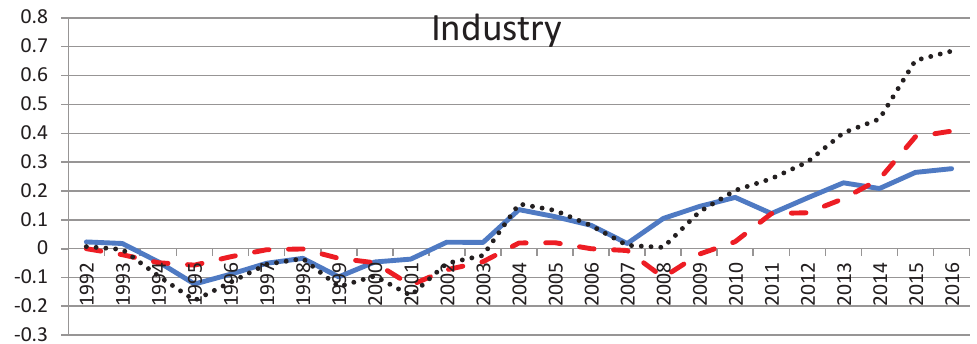
Figure 3 Contribution of composition effects to the wage growth, distinguishing between employers’ and workers’ characteristics, by sector.